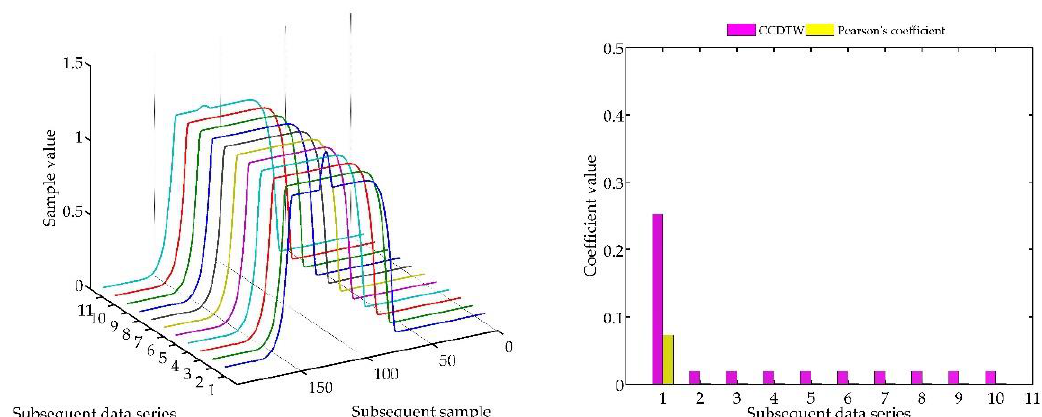
Figure 18. Simulation results achieved for non-shifted data for r ampl = 2.